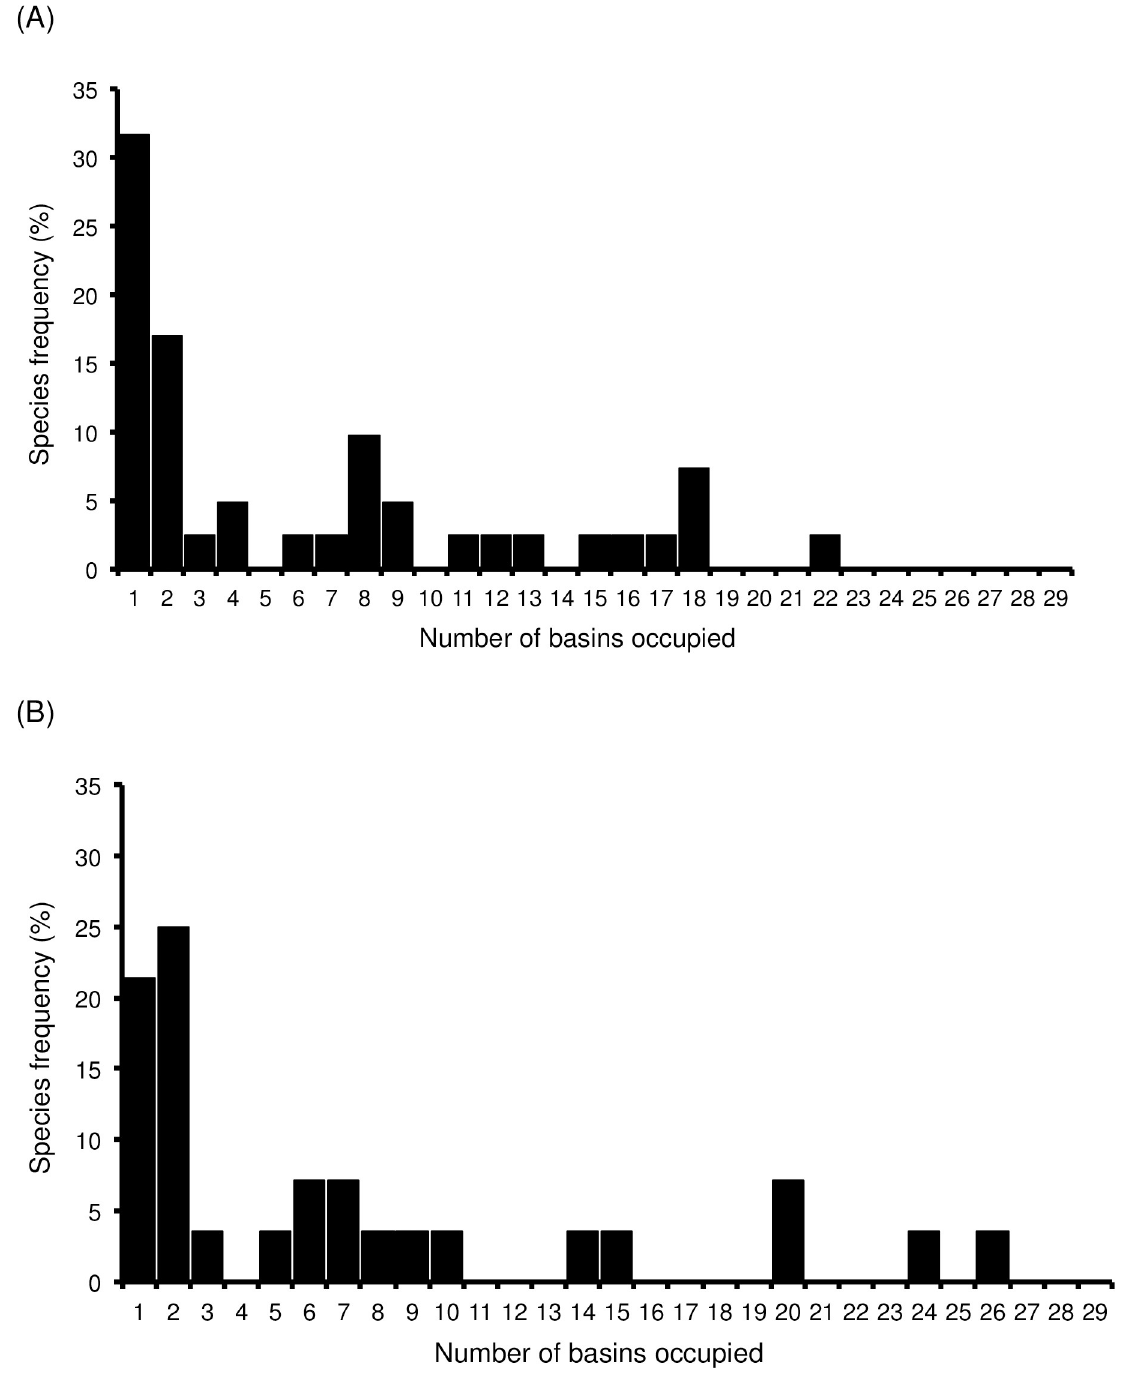
Fig 4. Basin occupancy (%) for 41 native and 28 naturalized freshwater fish species distributed in 29 basins in continental